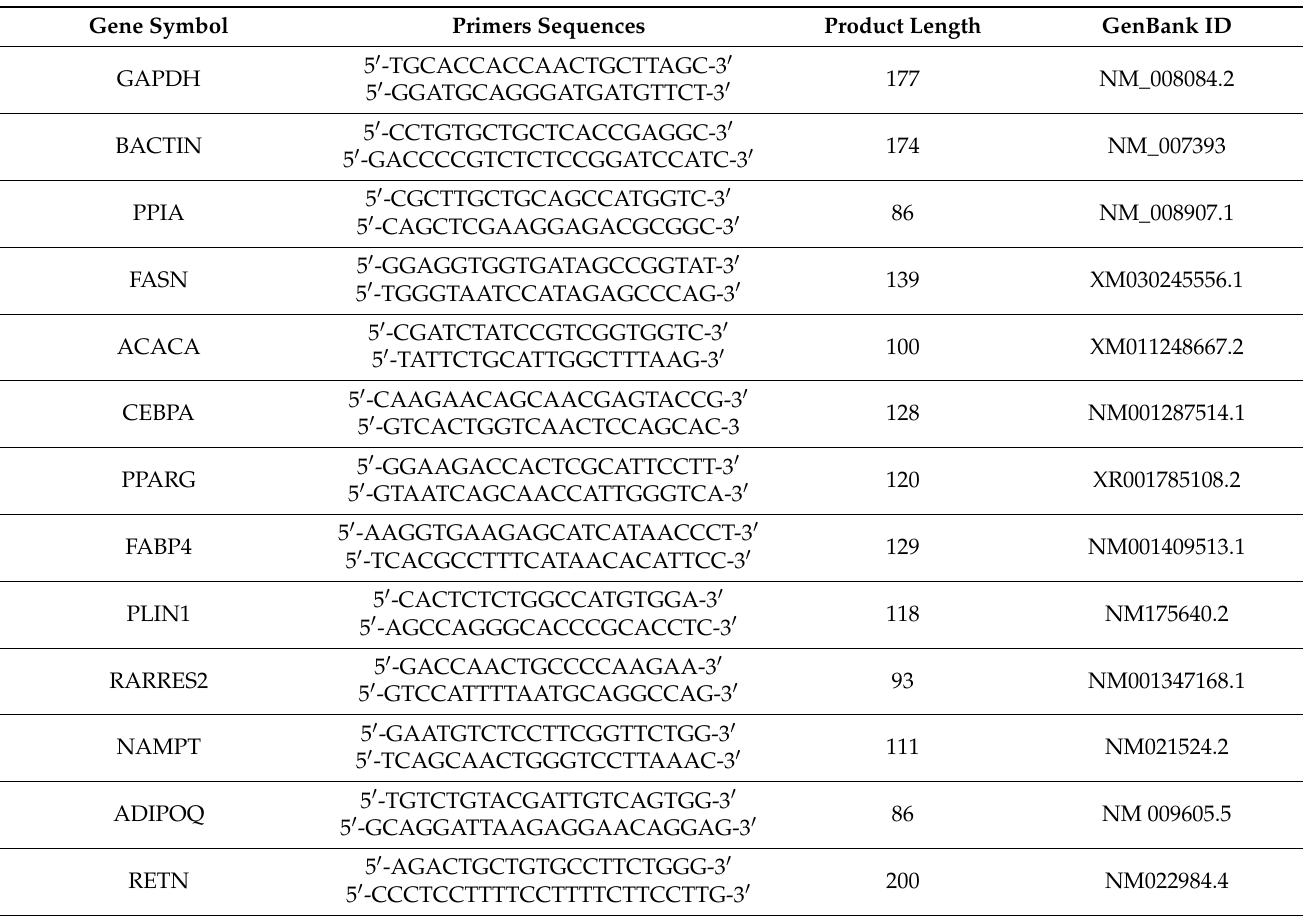
Table 9. Primers used for the